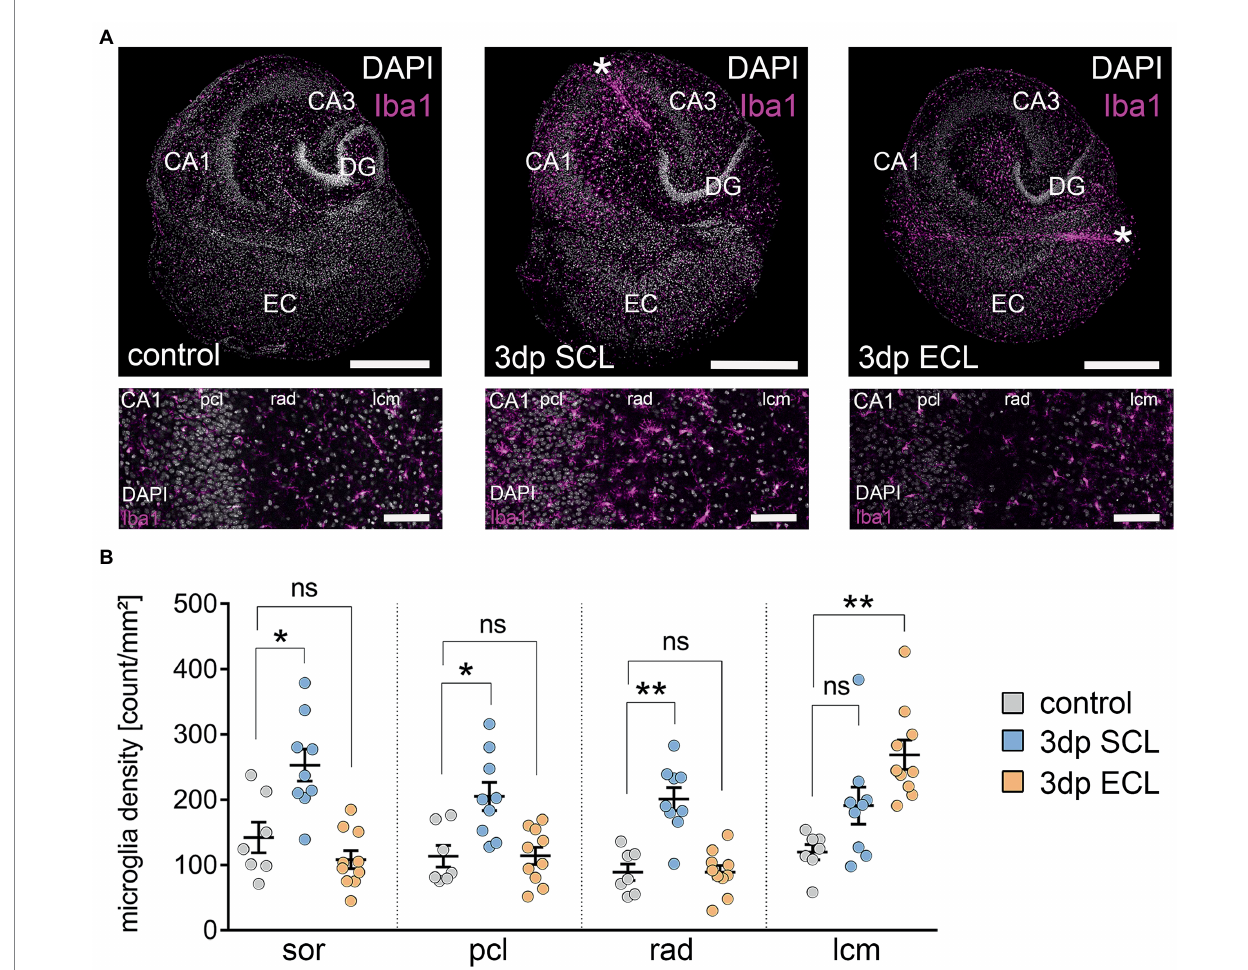
FIGURE 1 SCL and ECL both lead to layer-specific microglia accumulation in the CA1 region. (A) Representative examples of entorhino-hippocampal tissue cultures in non-lesioned controls (left panel) and 3 days after performing Schaffer collateral lesion (SCL, middle panel) or entorhinal cortex lesion (ECL, right panel) stained with DAPI nuclear stain and for the microglia marker Iba1 (EC, entorhinal cortex; DG, dentate gyrus; 3dp, 3 days post lesion; *, lesion). Higher magnifications (bottom row) illustrate the laminar accumulation of microglia in the CA1 region upon lesion (pcl, pyramidal cell layer; rad, str. radiatum; lcm, str. lacunosum-moleculare). Scale bar, 600 μ m (upper panels) and 100 μ m (bottom panels). (B) Microglia density was significantly increased in the str. oriens (sor), str. pyramidale (pcl) and str. radiatum (rad) following SCL while it remained unchanged in these layers after ECL. However, in the str. lacunosum-moleculare (lcm) microglia density was specifically increased following ECL but not SCL (n control = 7 cultures, n SCL = 9 cultures, n ECL = 10 cultures, Kruskal-Wallis test followed by Dunn’s posthoc correction). Individual data points are indicated by colored dots. Values represent mean ± s.e.m. (* p < 0.05, ** p < 0.01, ns - non significant